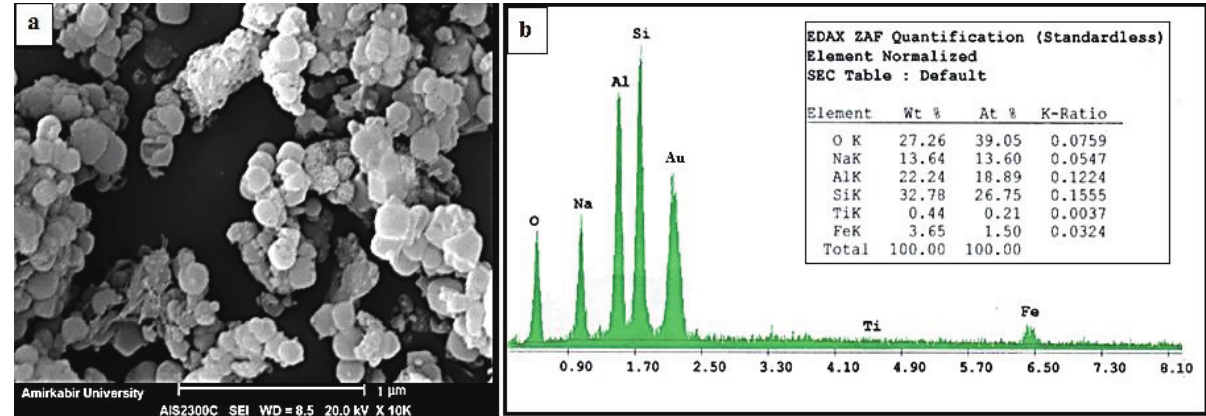
Figure 3: a)SEM image of M 4A, b) EDX of M 4 4